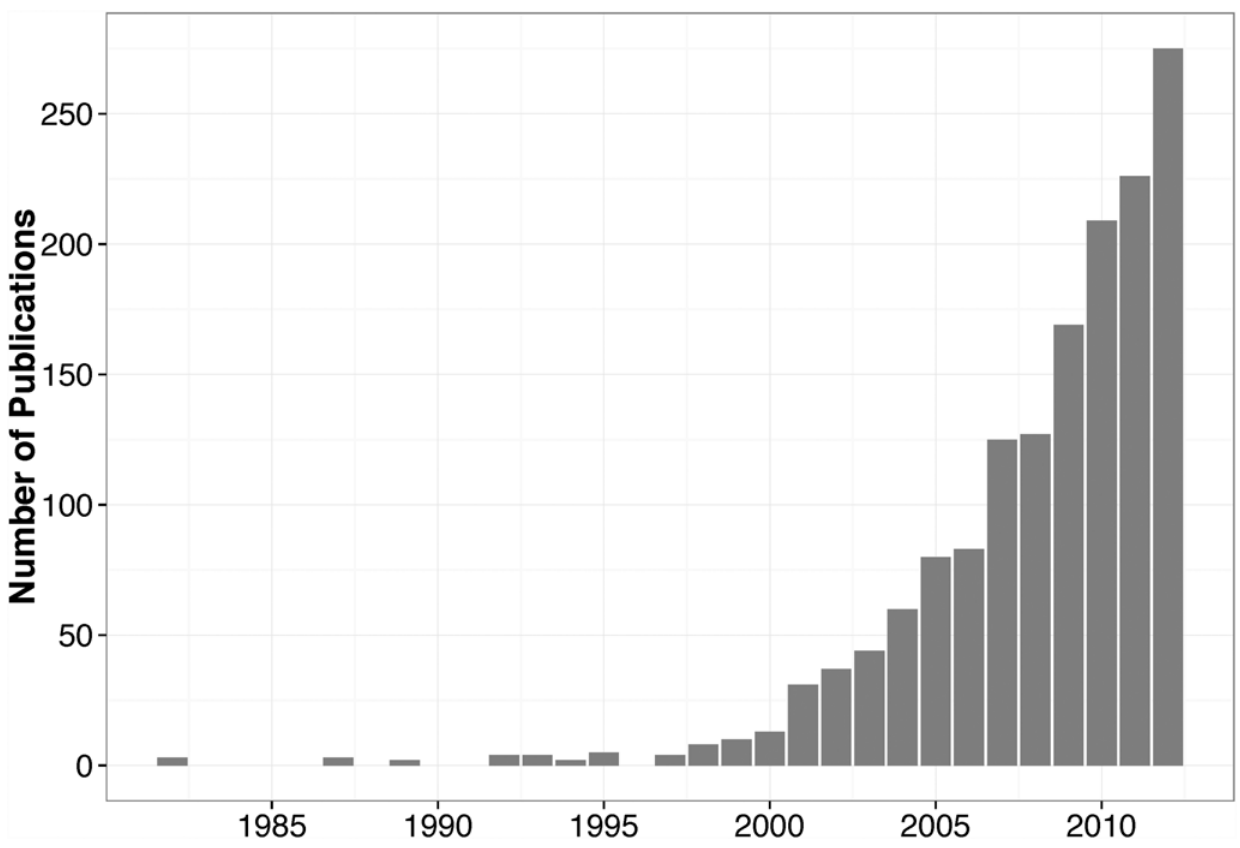
Fig 1. The annual number of articles published on CRTs (either trials themselves or methods for trials) has increased from 4 to 275 since 1997. Source: Web of Science. Search syntax used: (TI = ( “ cluster random * ” ) OR TI = ( “ group random * ” )) AND Document Types = (Article).